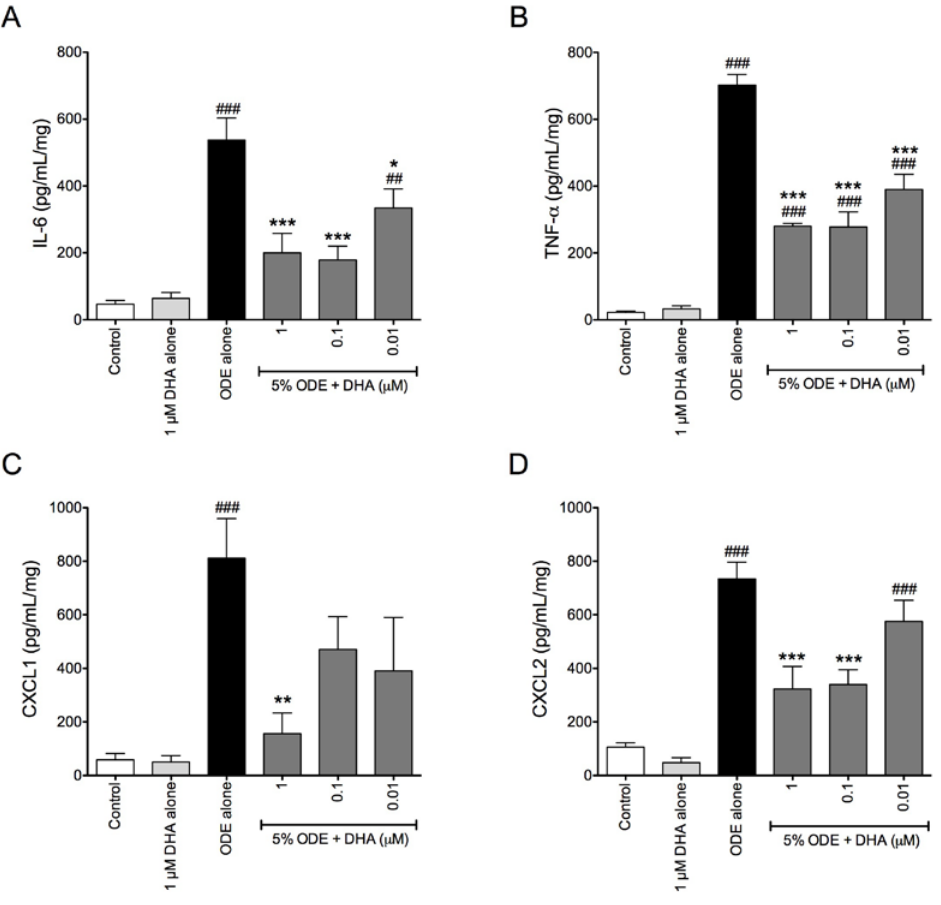
Figure 4. DHA pretreatment reduces ODE-induced IL-6, TNF-α, CXCL1, and CXCL2 release from precision-cut mouse lung slices. Precision-cut mouse lung slices were pretreated for 18 h with 0, 0.01, 0.1, or 1 μM DHA prior to 6 h treatment with 5% ODE. Following 6 h treatment, supernates were collected from the lung slices and IL-6 ( A ); TNF-α ( B ); CXCL1 ( C ); and CXCL2 ( D ) levels were determined via ELISA. ## p ≤ 0.01 vs. control; ### p ≤ 0.001 vs. control; * p ≤ 0.05 vs. 5% ODE alone; ** p ≤ 0.01 vs. 5% ODE alone; *** p ≤ 0.001 vs. 5% ODE